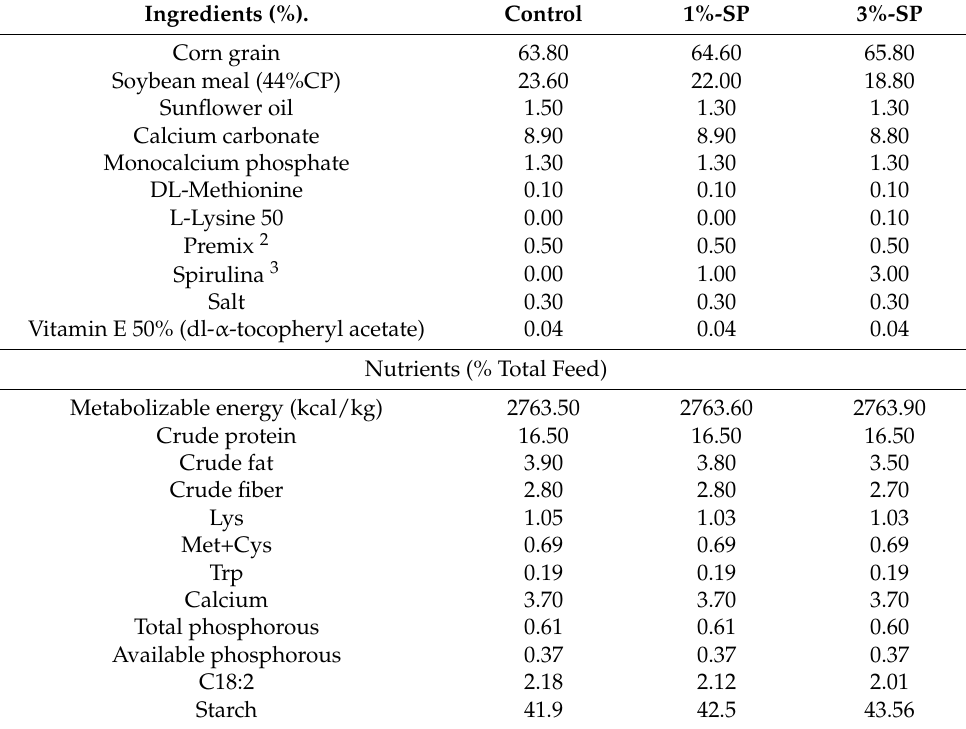
Table 1. Composition and calculated major nutrients of the experimental diets 1 . Ingredients